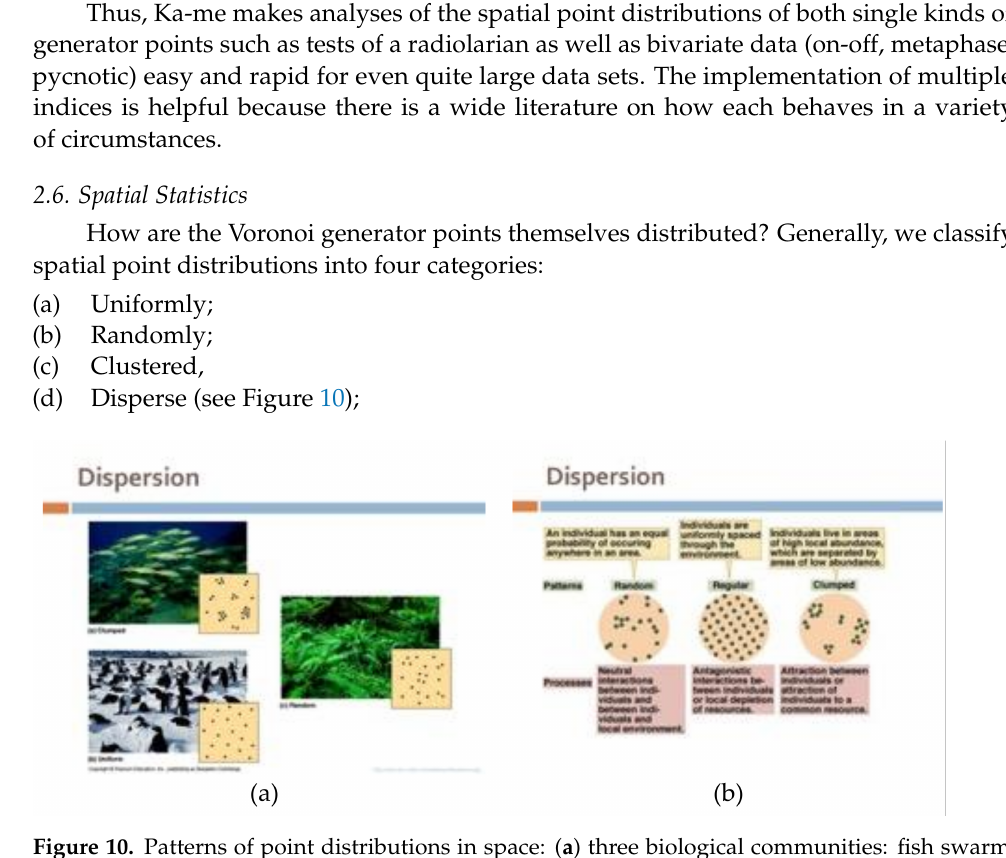
Figure 10. Patterns of point distributions in space: ( a ) three biological communities: fish swarm, penguins on ice, and corals. ( b ) Biological assumptions about each of these three patterns: random patterns are presumed to be the result of “neutral interactions between individuals and the local environment;” regular [uniform] patterns are presumed to be the result of antagonistic interactions between individuals or local depletion of resource; clumped patterns are presumed to be the result of attraction between individuals or attraction of individuals to a common resource. Source: https: //www.slideshare.net/thelawofscience/population-growth-22514883 (accessed on 25 October